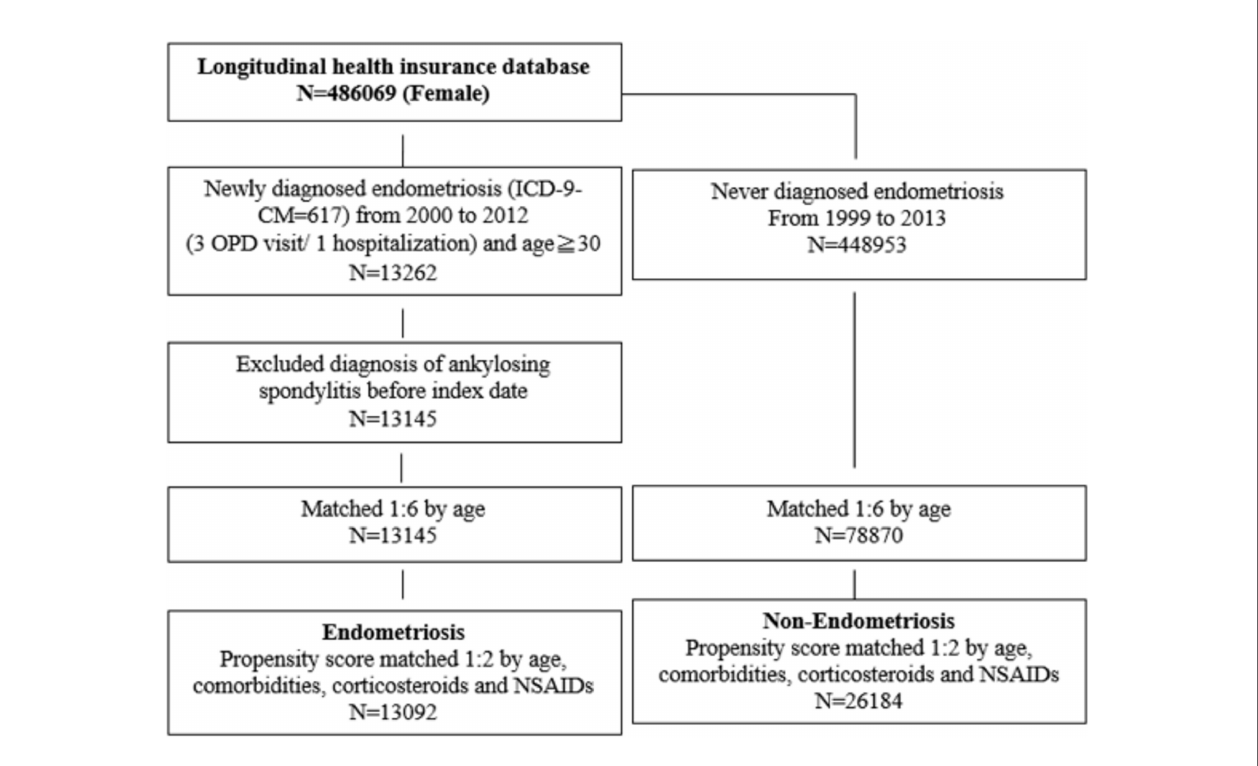
FIGURE 1 | The enrolling criteria of this